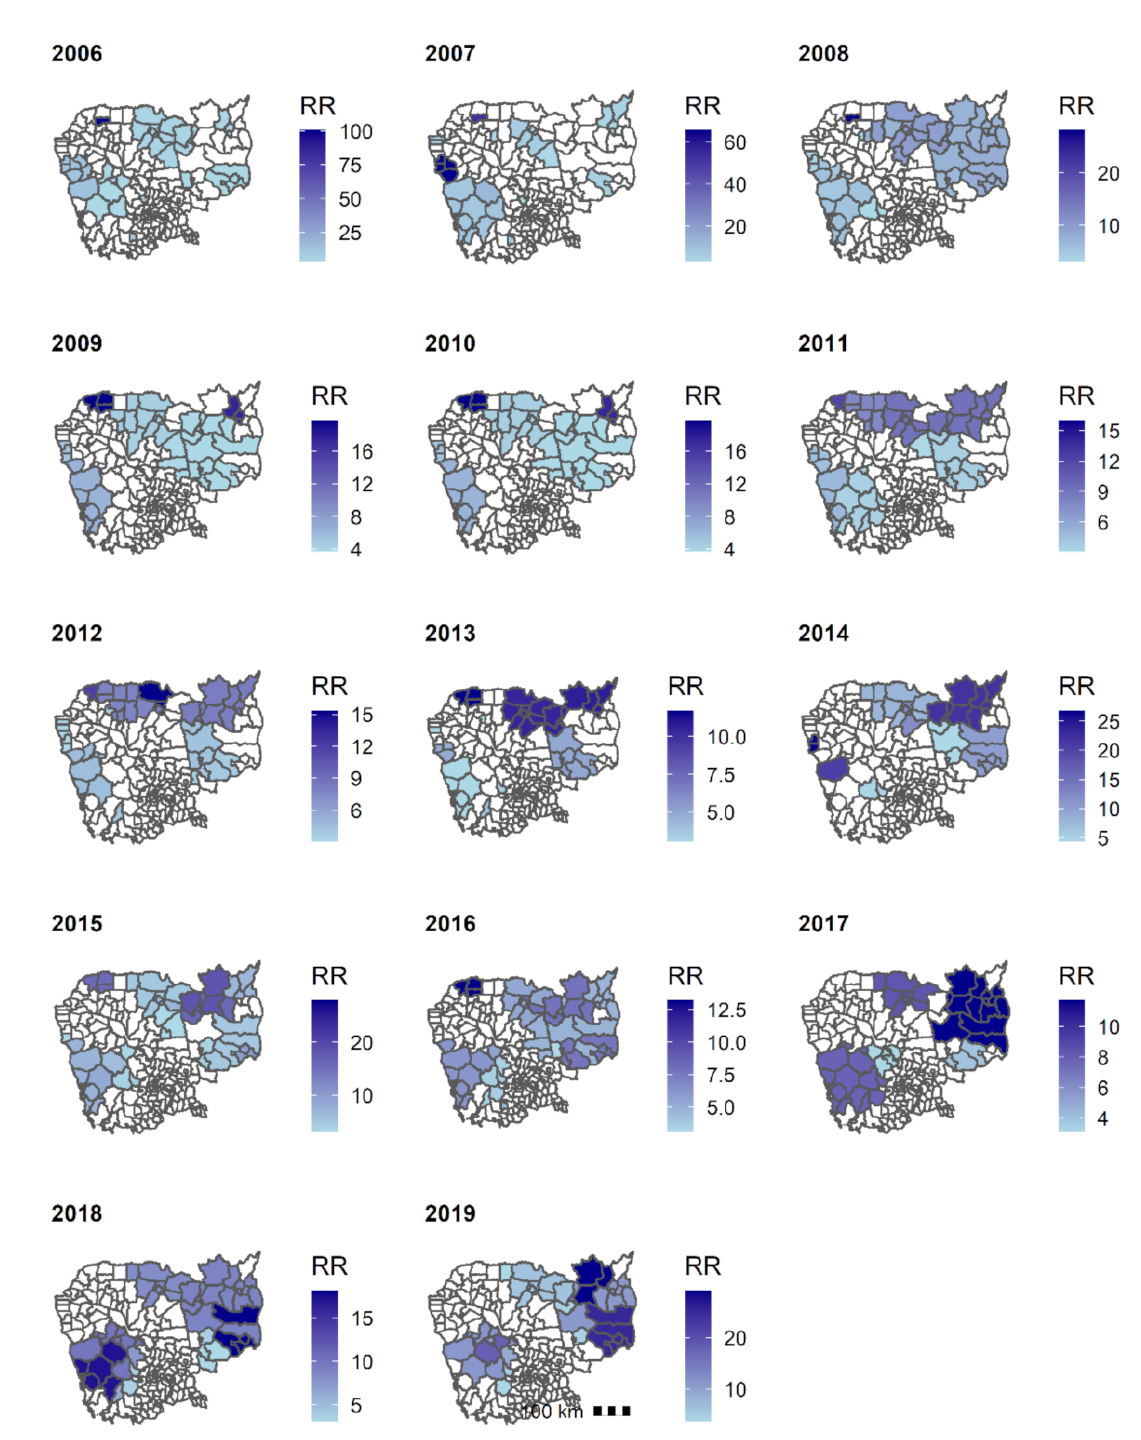
Figure 8. Clusters of confirmed P. vivax + Mixed cases, 2006–2019, Cambodia. Abbreviation: RR, relative